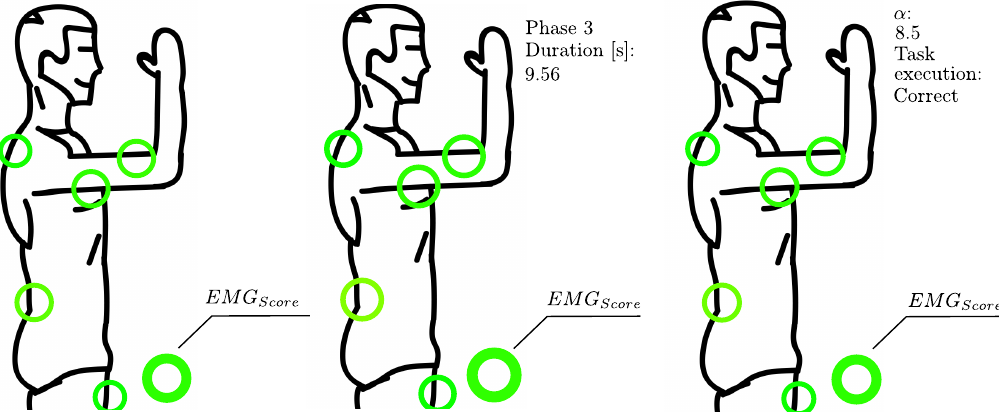
Figure 3. ( Left ) Example of image shown during the real-time acquisition; ( Center ) example of image shown during the final ergonomic assessment related to a generic phase; ( Right ) example of image related to the assessment of the whole